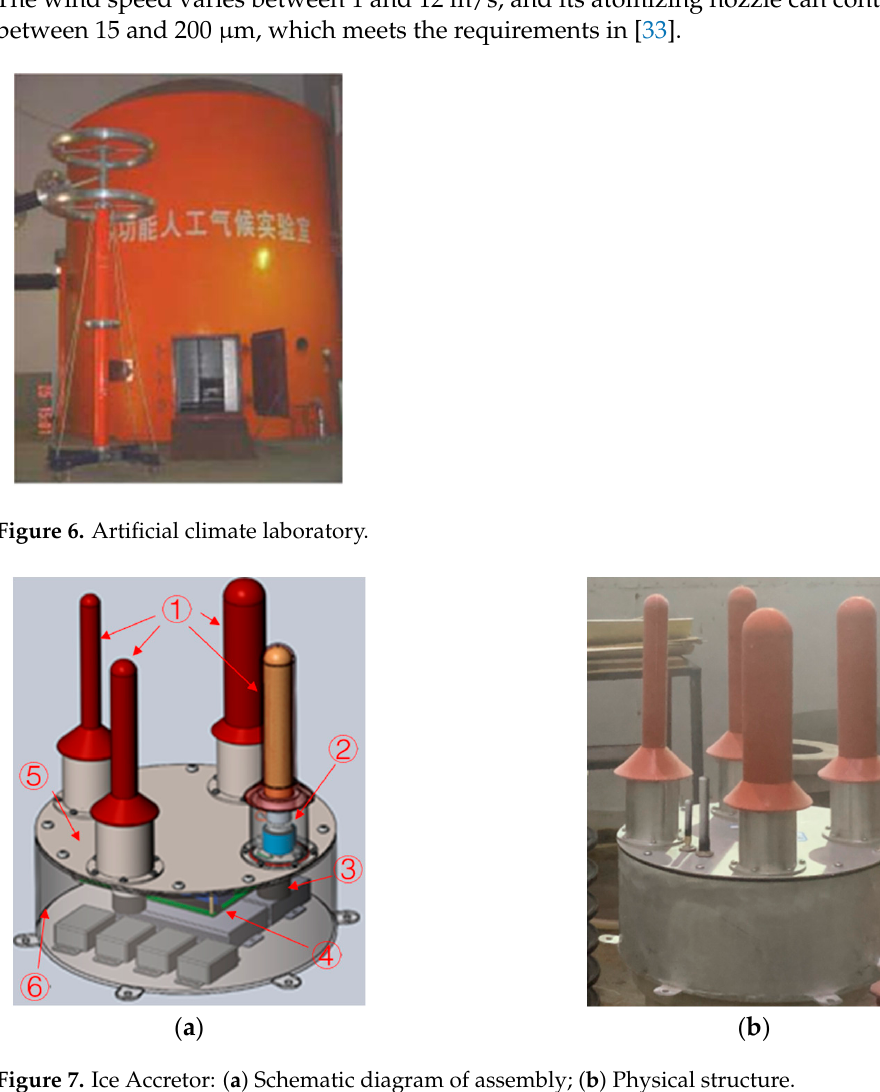
Figure 7. Ice Accretor: ( a ) Schematic diagram of assembly; ( b ) Physical structure.